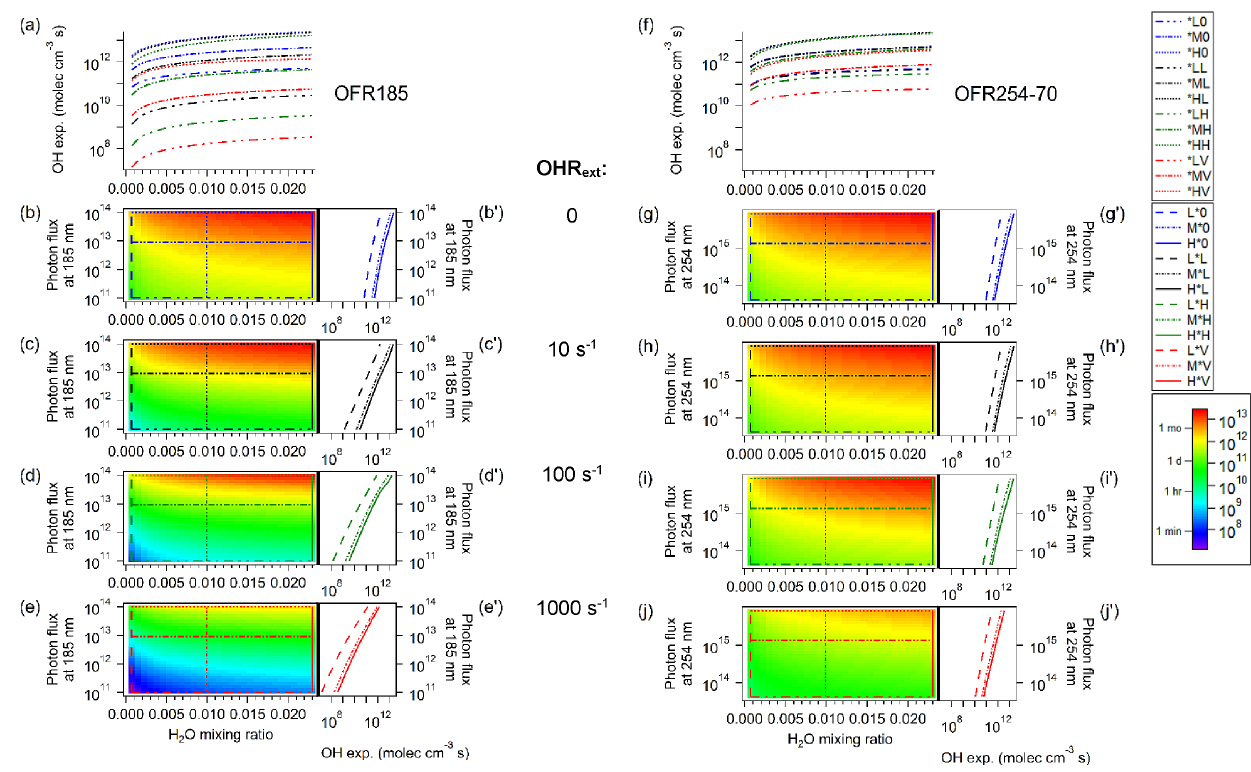
Figure 2. Dependence of OH exposures (in moleculescm − 3 s) in OFR185 and OFR254-70 on H 2 O and UV, for OHR ext of (b, g) 0, (c, h) 10, (d, i) 100, and (e, j) 1000s − 1 . (a, f) and (b (cid:48) – j (cid:48) ) are the line plots of OH exposures of several typical cases. These cases are denoted in the image plots (b–j) by horizontal or vertical lines of the same color and pattern as in the line plots. In detail, the cut lines are in blue, black, dark green, and red in the plots for the cases of 0, low, high, and very high external OH reactivity, respectively. Horizontal sparse- dash-dot-dot, dash-dot-dot, and dotted lines mark low, medium, and high water mixing ratios, respectively (first legend box). Vertical dashed, dash-dot, and solid lines mark low, medium, and high photon fluxes, respectively (second legend box). Refer to Table 1 for more details on case labels. The color scale corresponds to all image plots. Equivalent ambient exposure time (based on average ambient OH concentration of 1.5 × 10 6 moleculescm − 3 (Mao et al., 2009)) is also indicated in the color